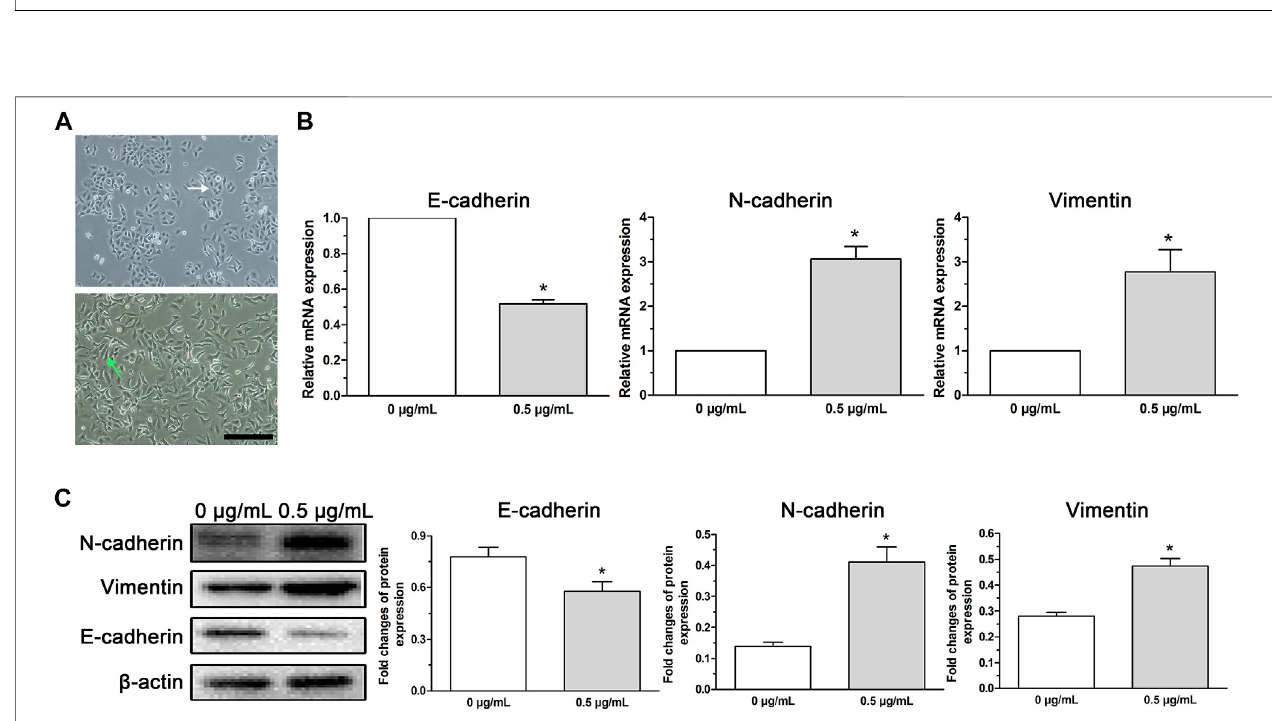
FIGURE 2 | EMT phenotype cells induced in A549 cells by low-dose cisplatin transient treatment. (A) Morphological observation of A549 cells under a light microscope.A549cellsincubatedwithlow-dosecisplatin(0.5 μ g/ml)presentedaspindle-likeshapeandirregularcellarrangement(magni fi cation:×100,scalebar=100 um). (B,C) EMT-related markers (E-cadherin, N-cadherin, and vimentin) were evaluated by RT-PCR and Western blot, respectively. As shown in (B,C) , mesenchymal markers (N-cadherin and vimentin) were upregulated whereas epithelial marker (E-cadherin) was downregulated in A549 cells treated with low-dose (0.5 μ g/ml) cisplatin compared with that of controls both at the mRNA and protein levels (* p < 0.01). Each experiment was conducted in triplicate and the data was expressed as mean ± SD.